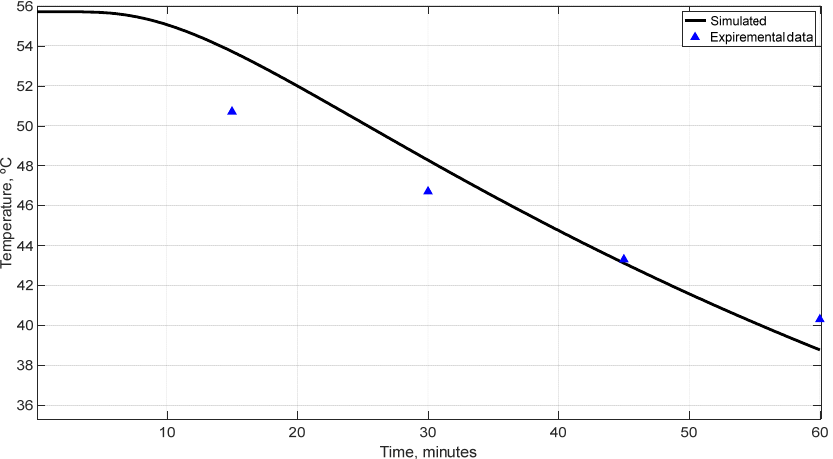
Figure 10. Comparison between experimental and simulated data for the PP temperature at the bottle centre.